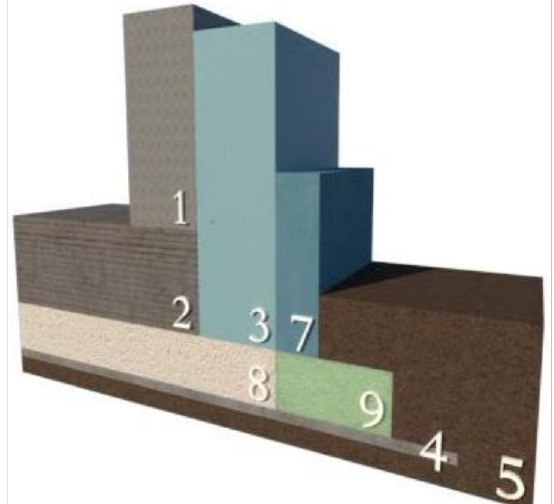
Figure 3. Insulation construction of wall corners. (1) Hollow brick walls. (2) Reinforced concrete raft slab foundations. (3) The 200 mm thick EPS board wall external insulation. (4) Concrete